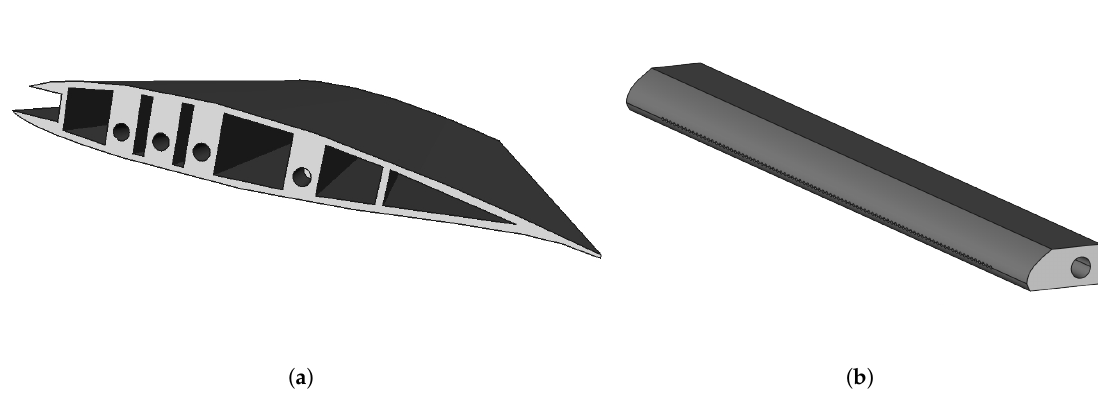
Figure 3. Computer-aided design (CAD) model of the airfoil, ( a ) main body without leading edge inserted and ( b ) leading edge insert without pins.